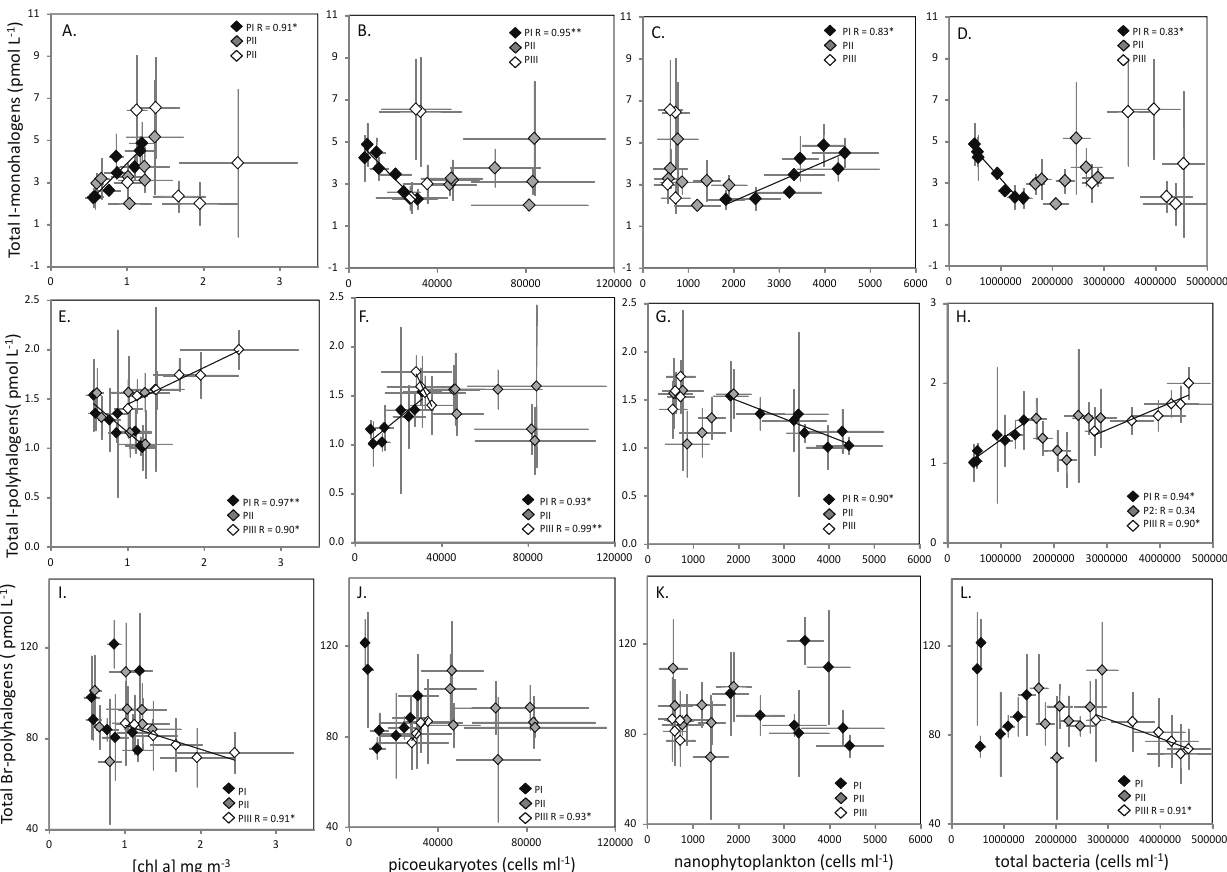
Fig. 3. Relationships between mean halocarbon concentration (pmol L − 1 ) and biological parameters ( L to R , chl a , picoeukaryotes, nanophy- toplankton, bacterial abundance). (A–D) total I-monohalocarbons (sum of CH 3 I, C 2 H 5 I, 2-C 3 H 7 I, 1-C 3 H 7 I), (E–H) total I-polyhalocarbons (sum of CH 2 I 2 and CH 2 ClI), (I–L) total Br-polyhalocarbons (sum of CHBr 3 , CH 2 Br 2 , CHBr 2 Cl, CH 2 BrCl, CH 2 BrI). PI (black diamonds), PII (grey diamonds) and PIII (open diamonds). Error bars indicate range of all data from all mesocosms. Asterisks denote significance level of correlation ( R ): ∗ = p < 0.05, ∗∗ = p <